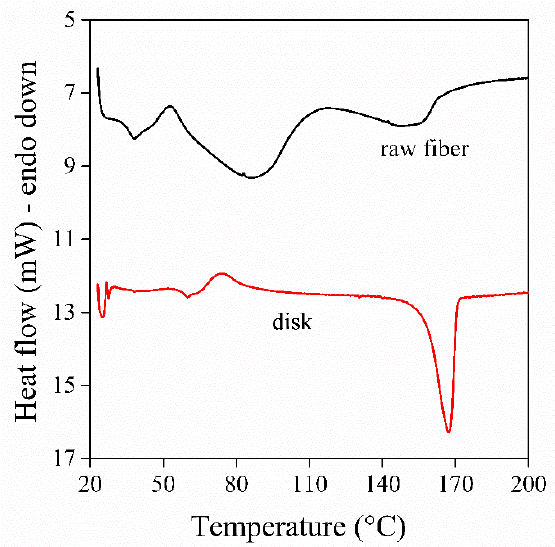
Figure 2. DSC traces recorded on the raw fibers and on a disk prepared from them after the evapo- ration of DMSO. Amox content: 0.96%.